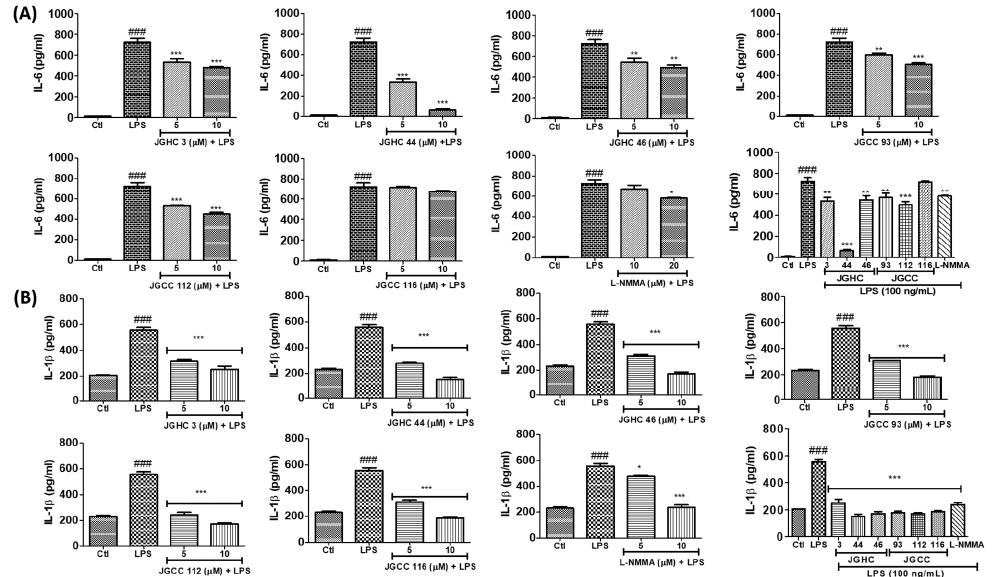
Figure 7. Active components from A. holophylla subfraction inhibited the production of IL-6 and IL-1 β against LPS-activated microglial cells. BV2 cells were pre-treated with 5 µ M of JHC 3, JGHCC 44, JGHC 46, JGCC 93, JGCC 112, and JGCC 116, and 20 µ M L -NMMA (positive control) and activated with LPS (100 ng/mL) for 24 h; cells and conditioned medium were used for the measurement of pro-inflammatory cytokines. ( A ) Effect on IL-6 production and ( B ) IL-1 β production. * p < 0.05, ** p < 0.01, and *** p < 0.001 indicate significant differences compared with treatment of LPS alone, while ### p < 0.001 indicates significant differences compared with the untreated control group. Ctl indicates untreated control cells, LPS indicates LPS-treated